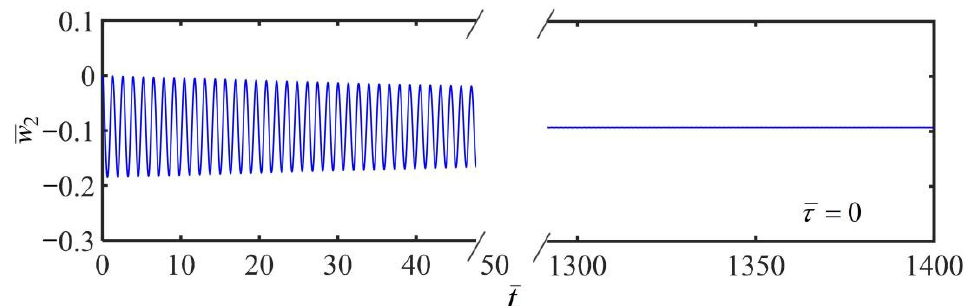
Figure 3. Variation of the displacement of the mass block with time during the damped free vibration of the system in a linear temperature field with a static frame. The vibration of the mass block stops in a static condition due to the damping consuming the energy.